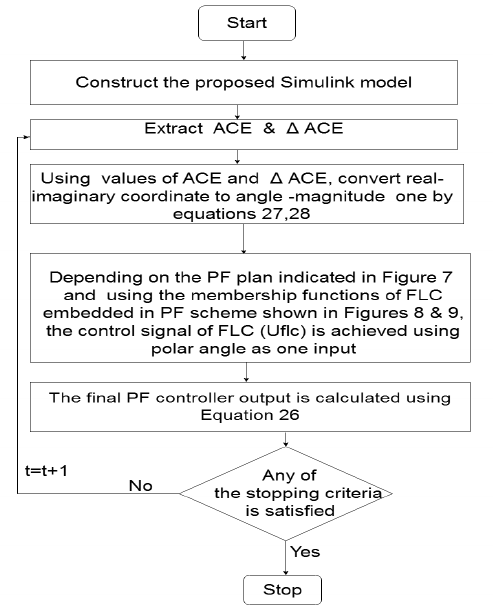
Figure 10. Flowchart of the PF scheme design process.